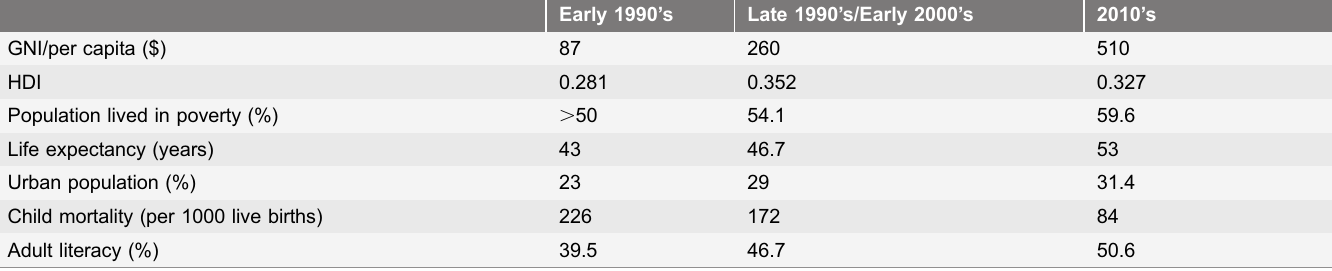
Table 1. Socio-demographic and health information from the 1990’s to the 2010’s for Mozambique